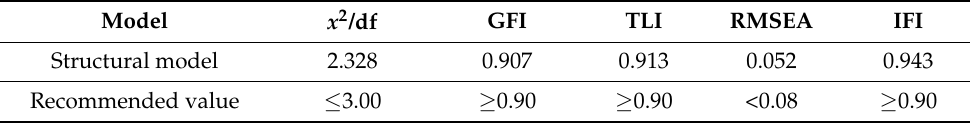
Figure 2. Results of structural equation modeling. *** p < 0.001; GFI = 0.907; TLI = 0.913; IFI = 0.943; RMSEA = 0.052. Table 3. Summary of Goodness-of-Fit Indices for the Structural